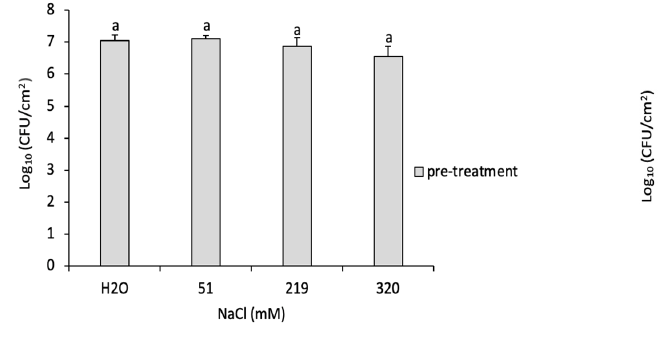
Figure 3. Impact of different pH values on P. putida planktonic cells ( a ) The viability of the pre ‐ treatment samples of planktonic cells after exposure to different pHs ( b ) The viability of the control samples (deionized water) or the post ‐ treatment samples (GO at 85 mg/mL) of planktonic cells after the exposure to a constant pH. Mean values with different letters are significantly different ( p < 0.05). Similar letters are non ‐ significantly different. The data were analyzed with one ‐ way ANOVA.